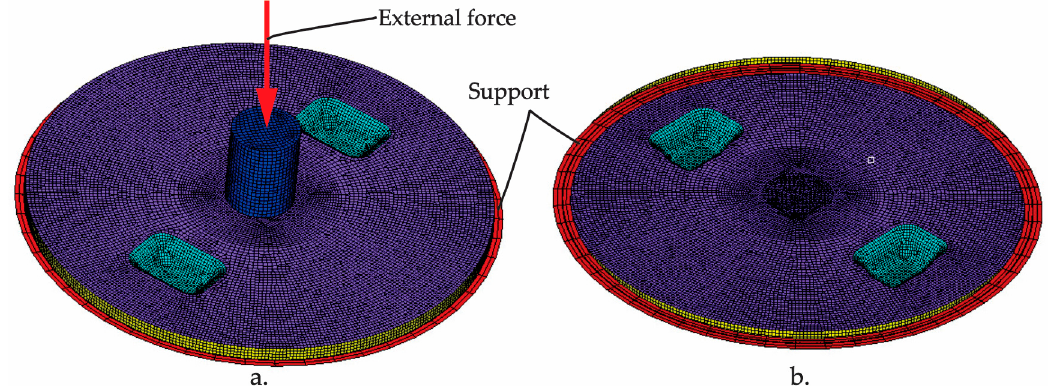
Figure 8. Finite element model of the manhole cover: ( a ) Top view; ( b ) bottom view. The S4 shell element having rectangular shape, with four nodes located in corners, is used in the